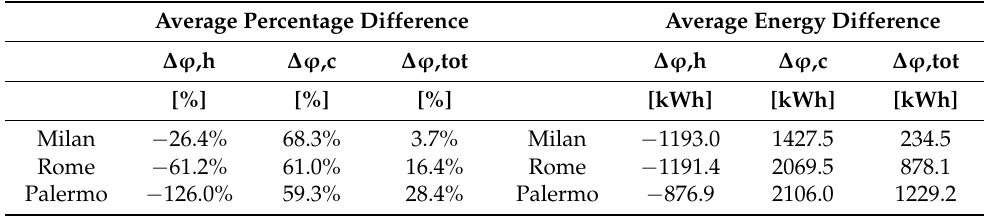
Table 9. Average percentage difference and average energy difference between the case study with g gl,n = 0.77 and g gl,n = 0.34. Δφ% = (φ_g gl ,0.77 − φ_g gl ,0.34)/ φ_g gl ,0.77. ΔkWh = (φ_g gl ,0.77 − φ_g gl ,0.34).